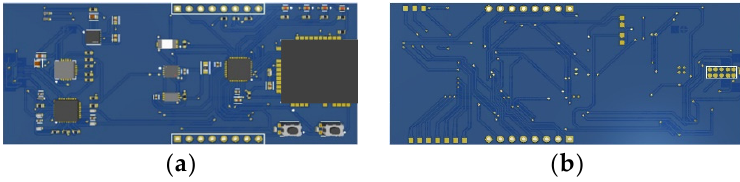
Figure 5. PCB design of wireless climate sensor node: ( a ) top layer; ( b ) bottom layer.